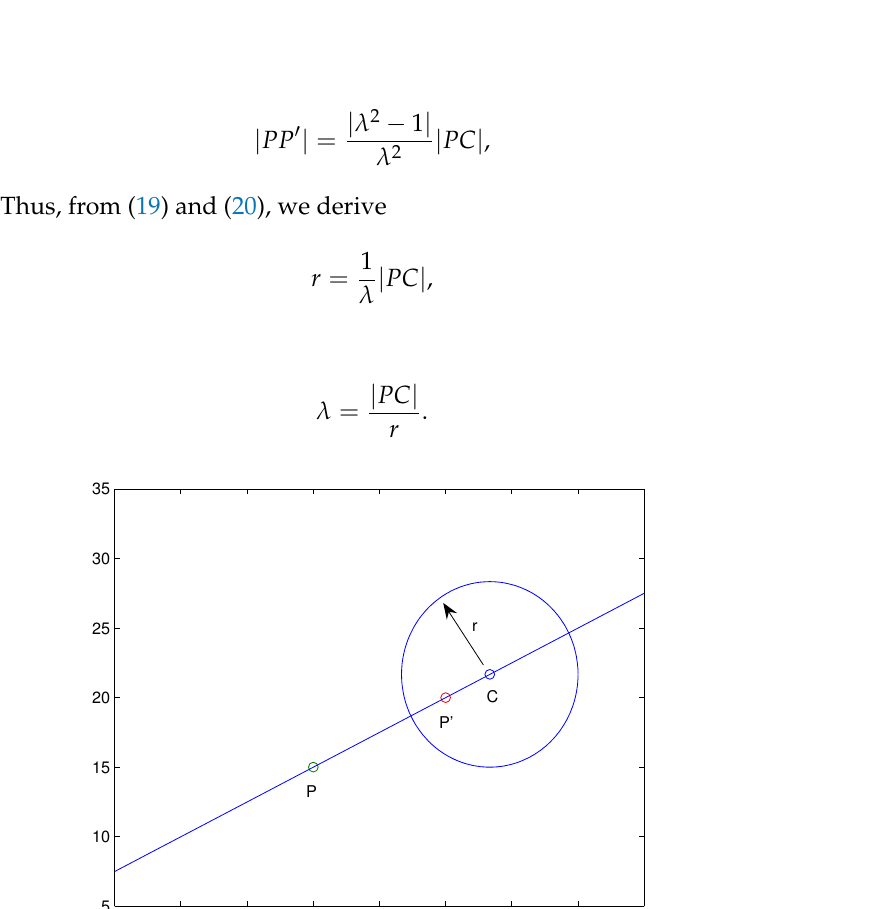
Figure 4. Calculation of P (cid:48) based on P and a